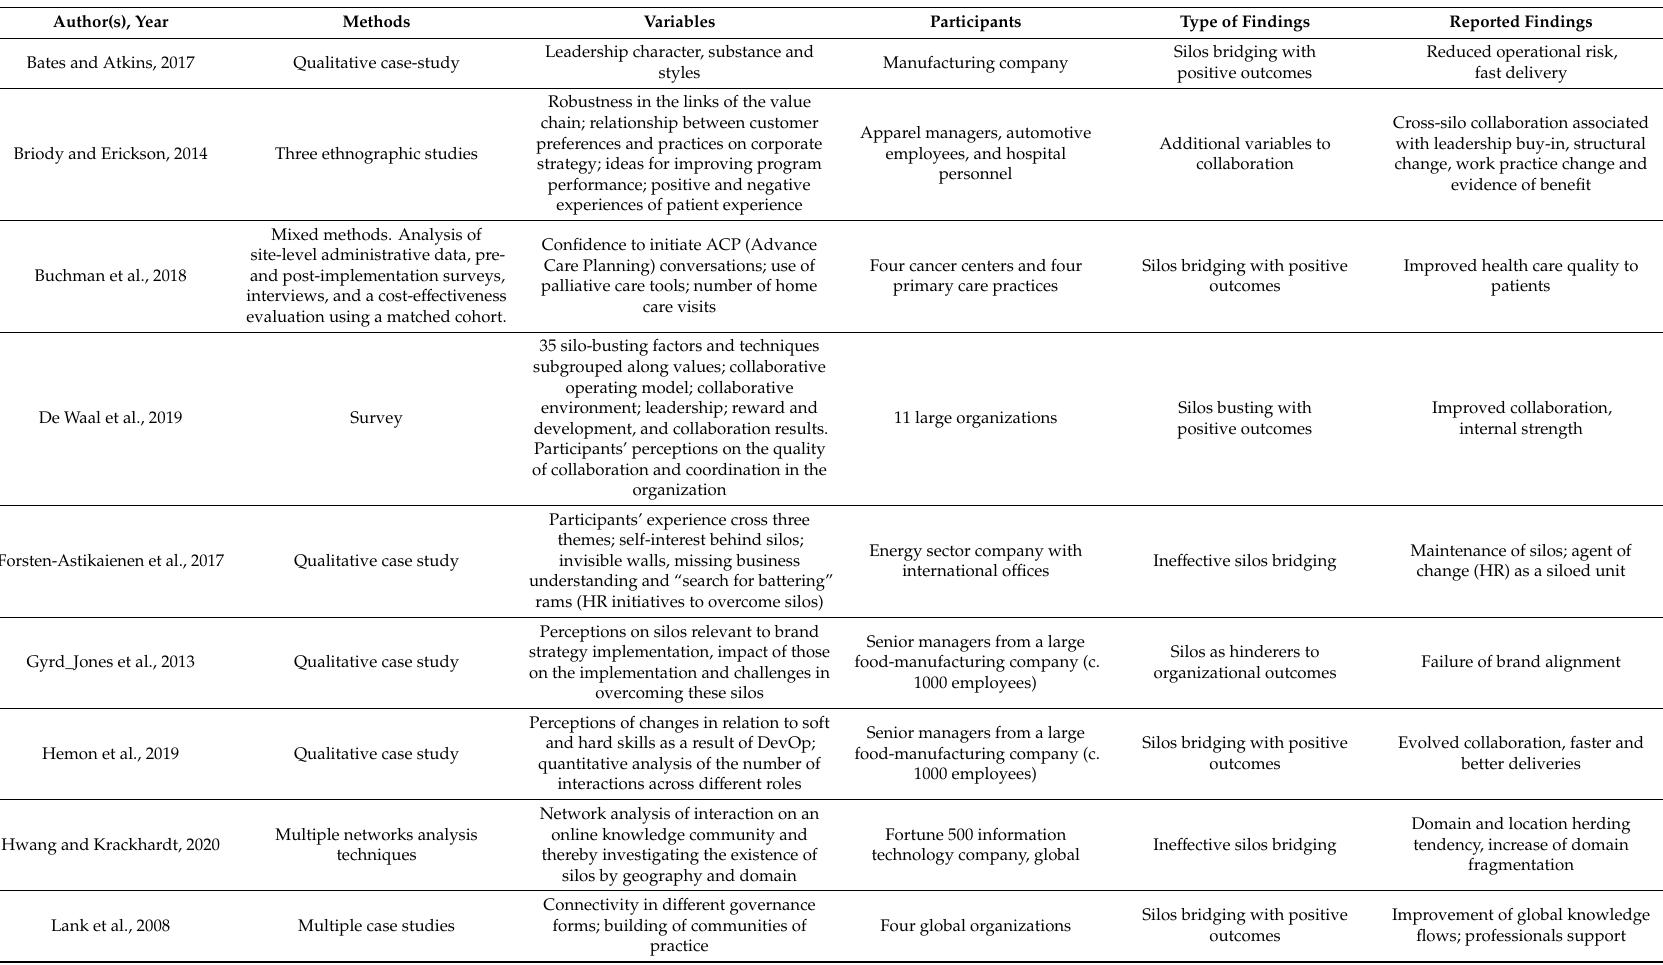
Table 2. Quantitative analysis of included empirical studies (experimental and applied) with measures and